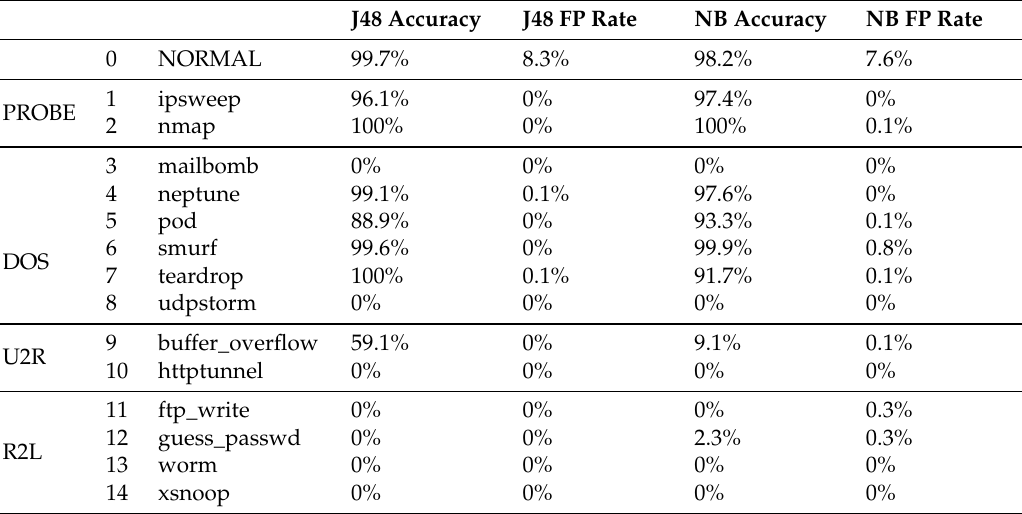
Table 9. Accuracy of sub-attack types obtained by two